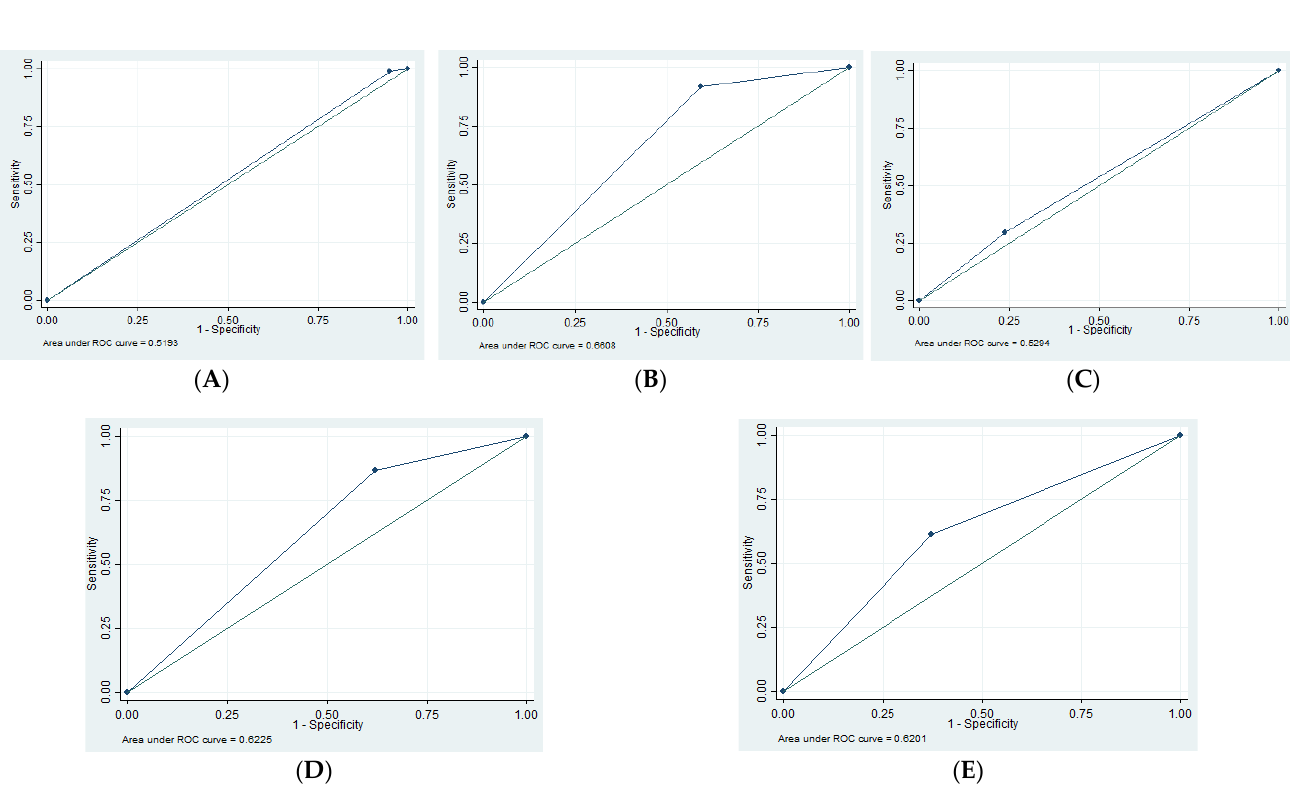
Figure 2. ROC for different parameters for diagnosis of death vs. survived. ( A ) ROC for EDH showing the AUC of 0.52. ( B ) ROC for edema showing the AUC of 0.66. ( C ) ROC for skull fractures showing the AUC of 0.53. ( D ) ROC for SDH showing the AUC of 0.62. ( E ) ROC for tSAH showing the AUC of 0.62.